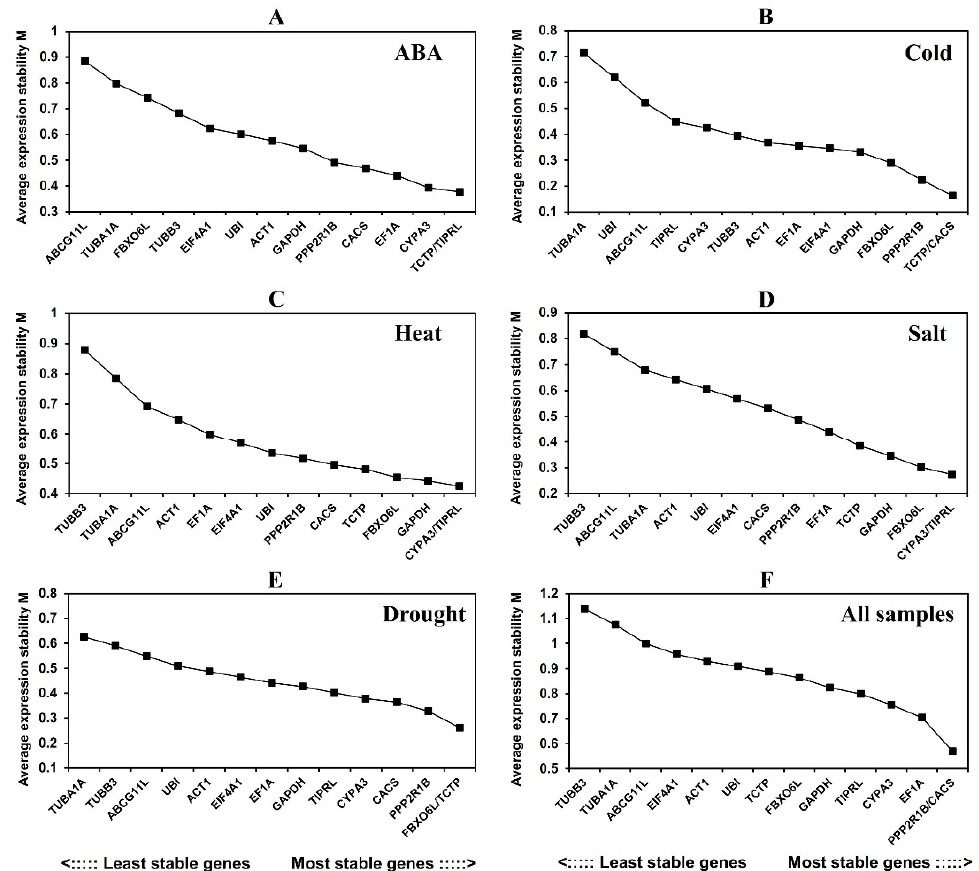
Figure 2. Average expression stability values (M) of fourteen candidate reference genes calculated by GeNorm.